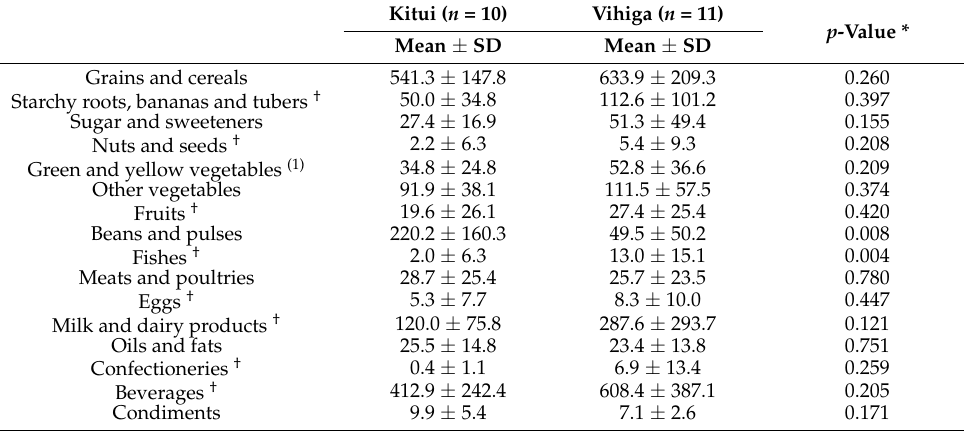
Table 3. Daily food group intakes in farm women in charge of meal